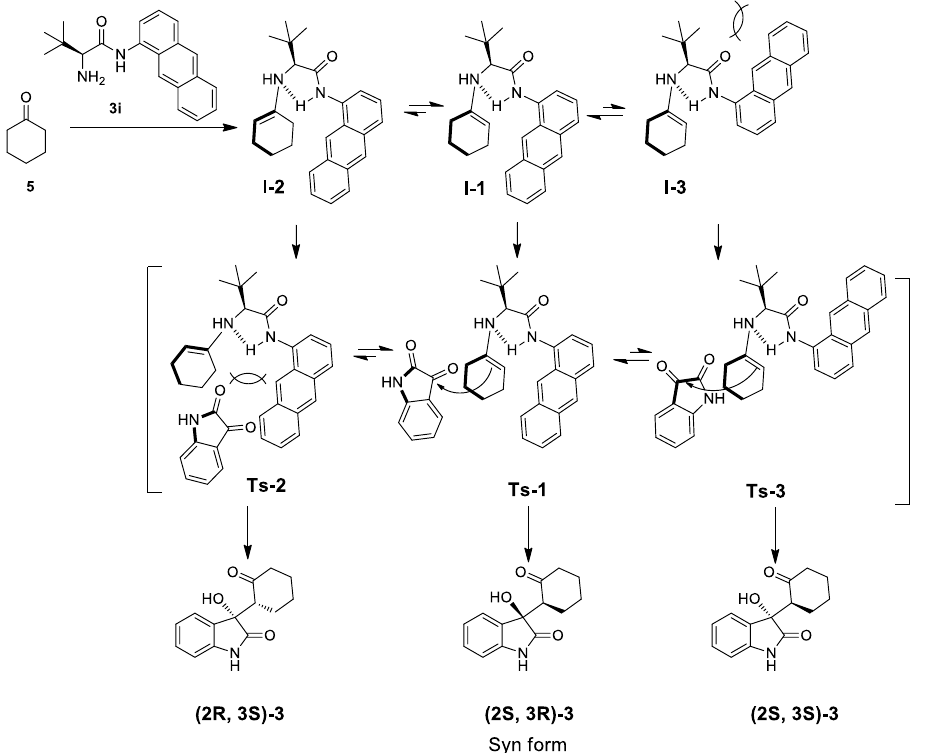
Scheme 6. Proposed mechanism of aldol reaction of isatin with cyclic ketones.